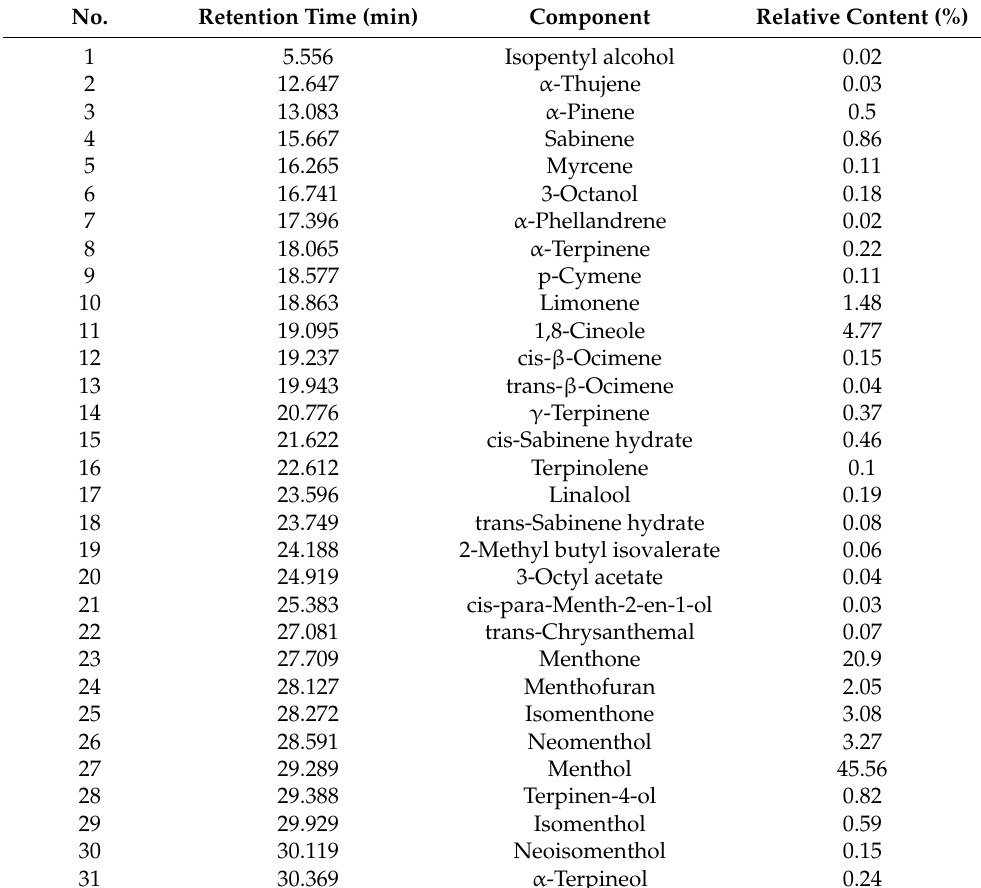
Figure 4. Metabolic pathway analysis of serum samples. Each circle in the figure represents a metabolic pathway. The color and size of the circle represent the p value and influence value of different metabolic pathways. The more red the color is, the more significant the result is, and the larger the circle is, the greater the influence value is. Table 6. Main chemical composition and the relative content in Peppermint essential